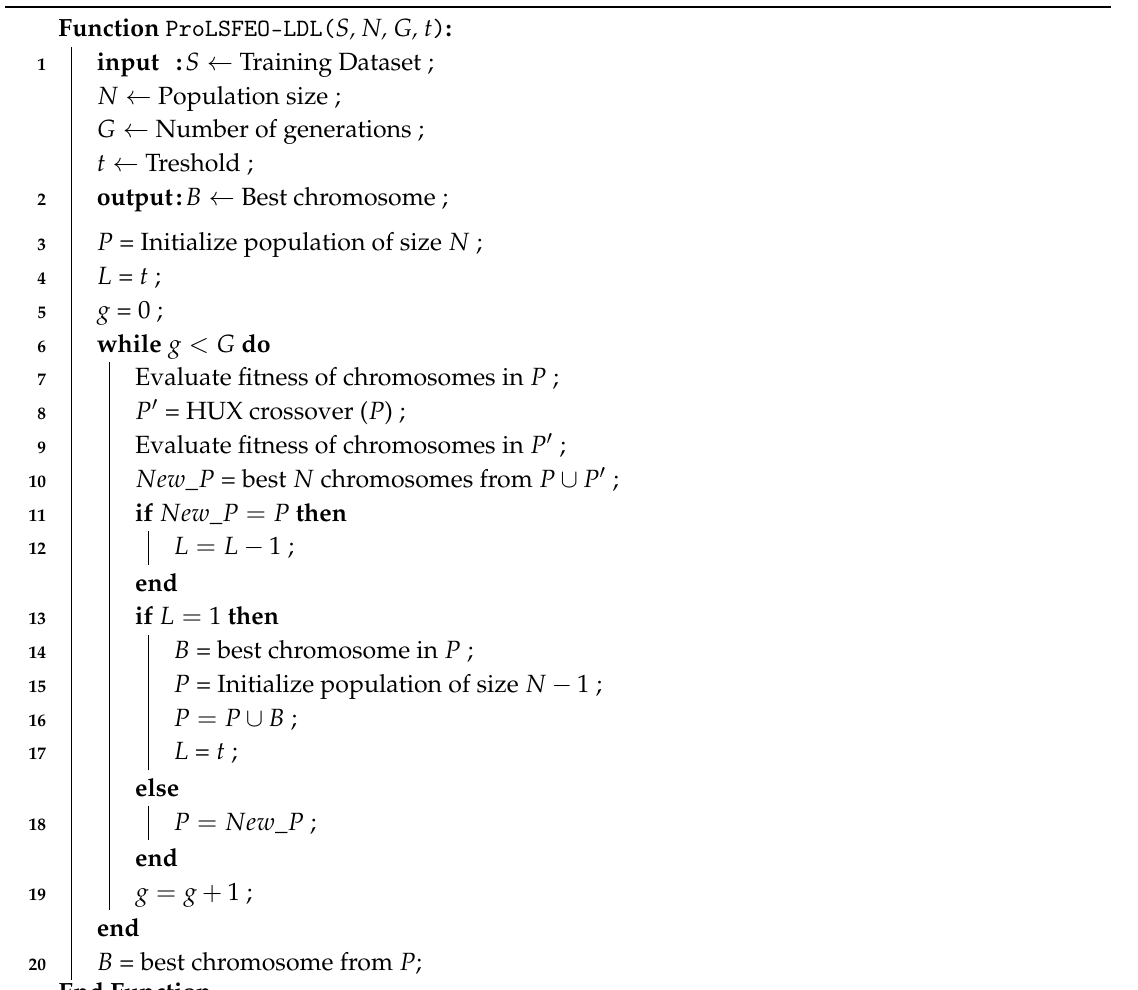
Algorithm 1: ProLSFEO-LDL: Prototype selection and Label-Specific Feature Evolutionary Optimization for Label Distribution